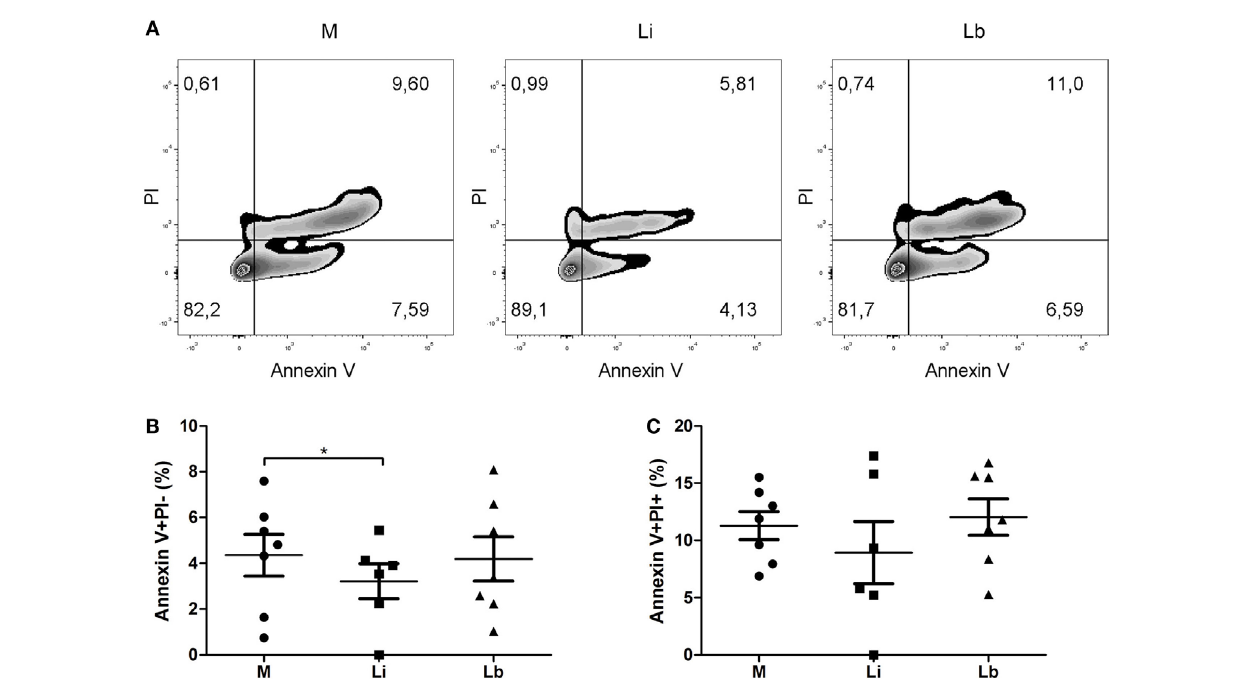
FigUre 5 | L. infantum delayed the cellular death of dendritic cells – flow cytometry gating strategy (a) to perform analyses of annexin V and propidium iodide (Pi) staining of control Dcs (M) or treated with viable L. infantum (li) or L. braziliensis (lb) . Annexin V positive cells (B) and annexin V and PI positive cells (c) . Median ± SD. Each point represents one donor. * p < 0.05, ** p <